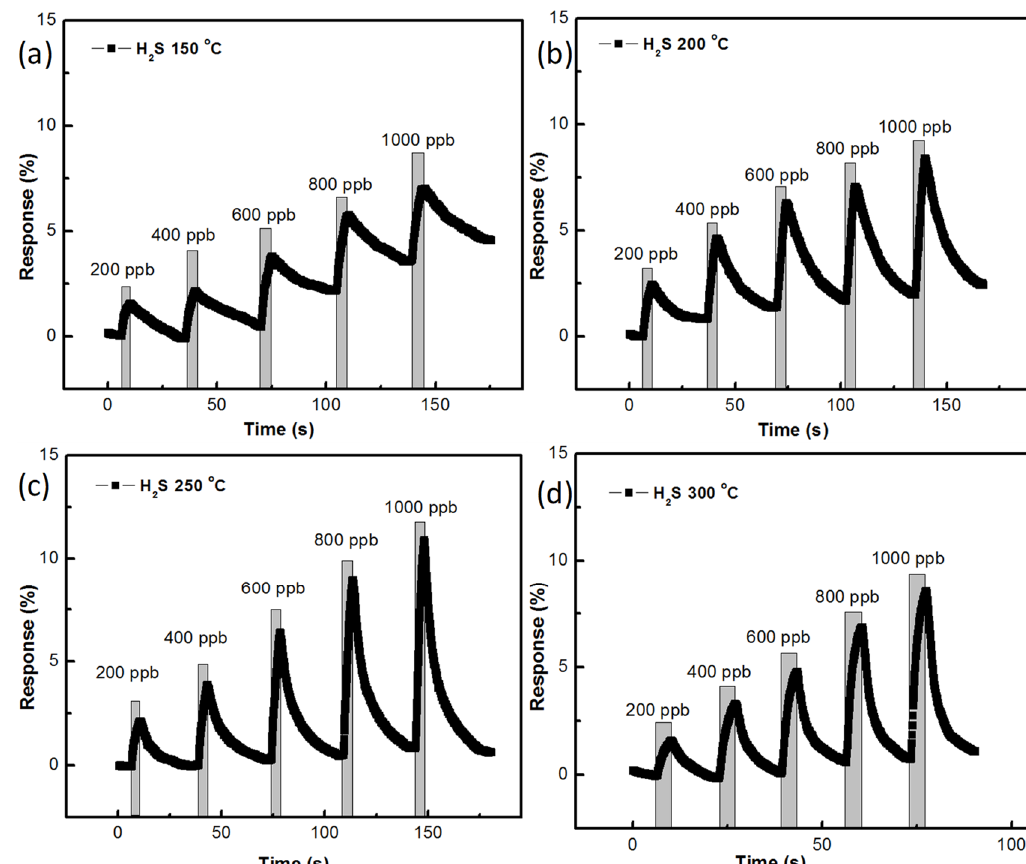
Figure 9. H 2 S gas-sensing response of ZnO nanostructure prepared with 45 min growth time: ( a ) at 150 °C, ( b ) 200 °C, ( c ) 250 °C, ( d ) 300 °C.